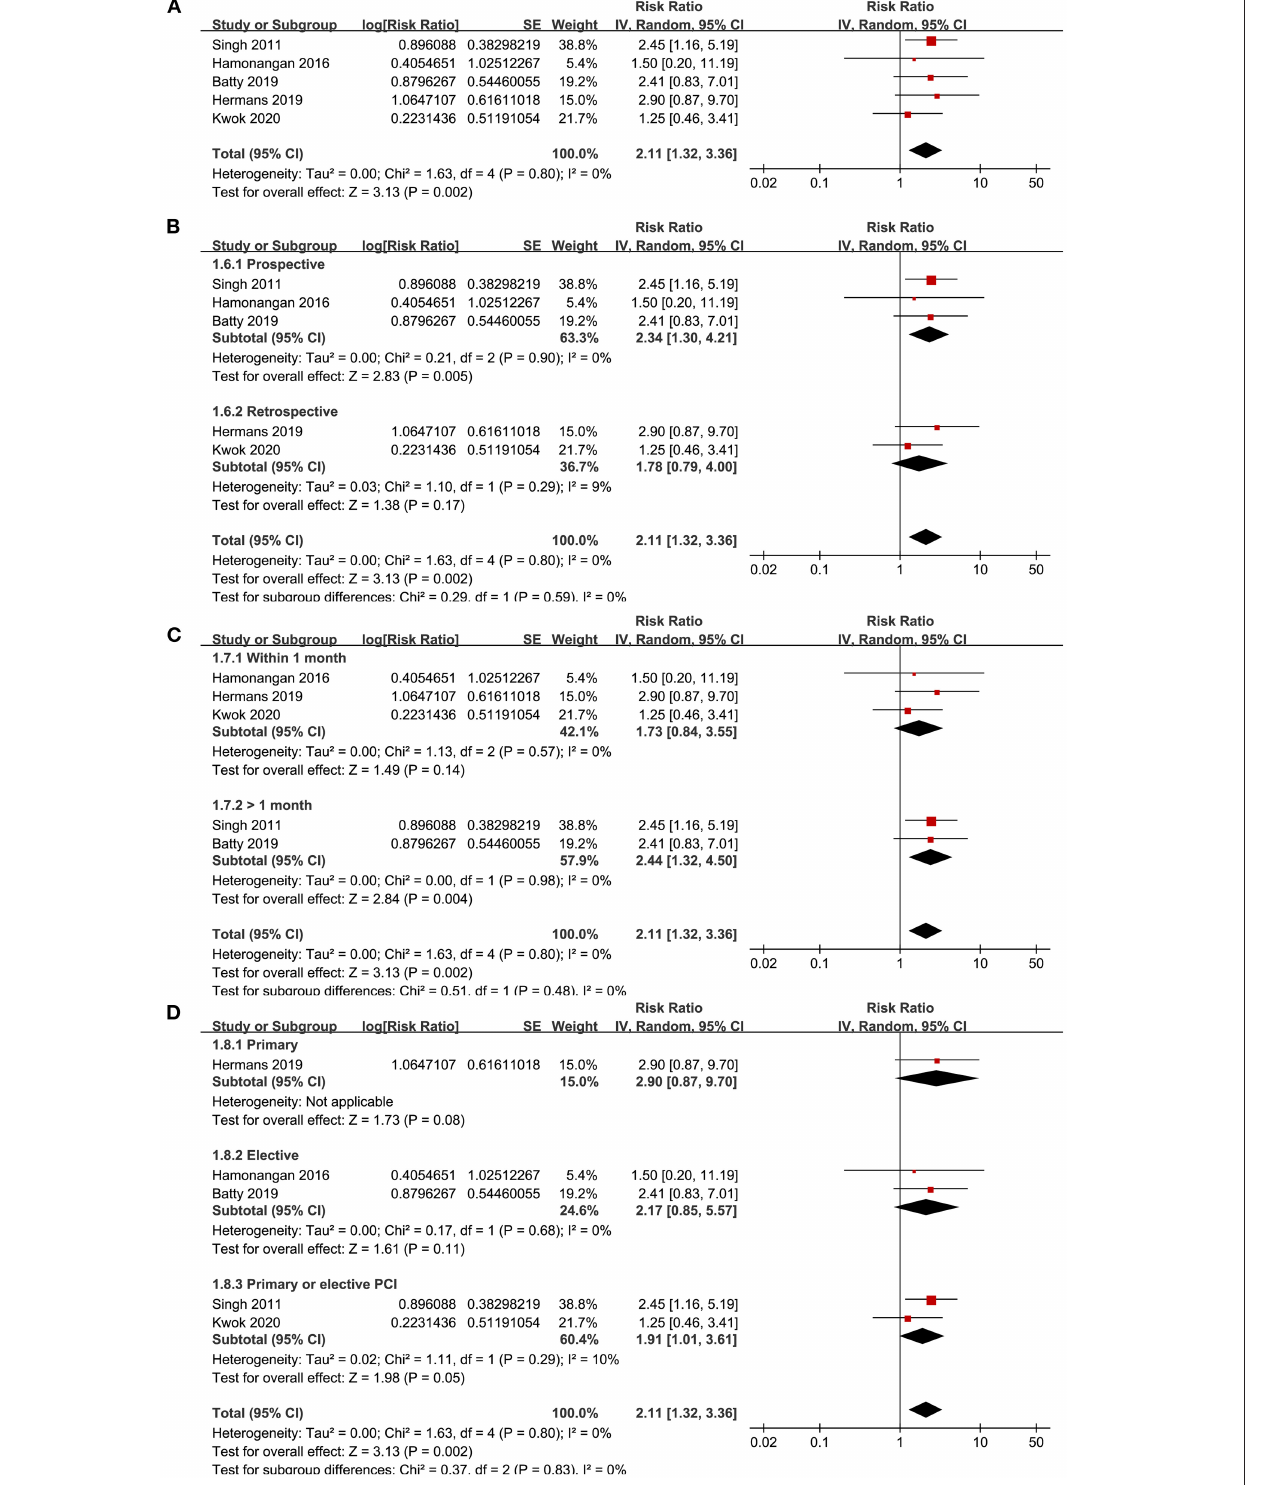
Frontiers in Medicine |